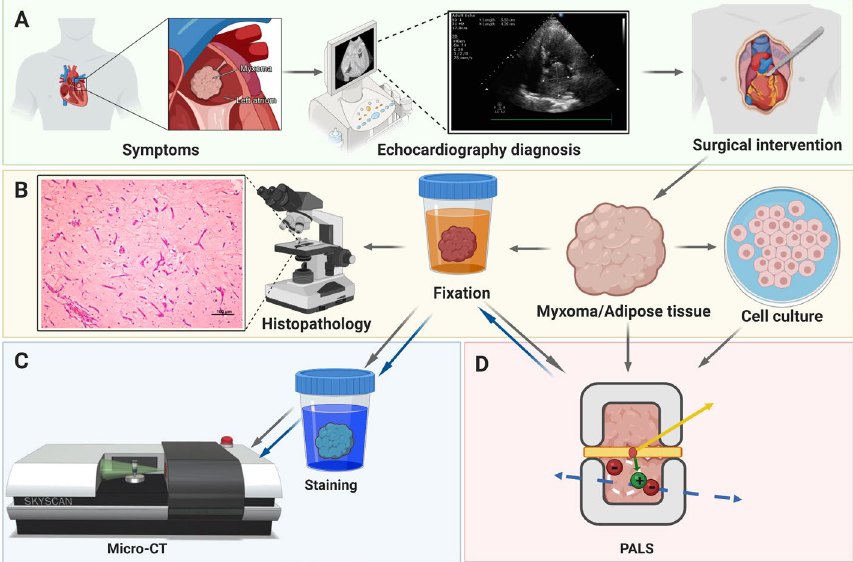
Fig. 3 Cardiac myxoma experiment workflow. a The clinical examination of a symptomatic patient by transthoracic echocardiography and surgical excision of cardiac myxoma (CM). b Sample preparation and examination of myxoma, adipose tissues and CM cells: one piece of CM was fixed for histopathology examination (H&E), while other piece of CM and adipose tissue samples have been used for studying their positronium properties and later fixed for the X-ray imaging (micro-CT). CM cell culture has been derived from the part of tissue designated for PALS experiment before fixation. c Micro-CT imaging: staining in Lugol solution for 5 days and micro-CT scanning; gray and blue arrows represent a workflow for two different scanning runs: before and after positronium measurement (PALS). d A chamber for ortho-Positronium lifetime measurement comprising CM or adipose sample with the 22 Na radionuclide (red dot) emits (green arrow) a positron ( ) and a prompt photon (yellow arrow). Positron and electron from a sample create a + positronium atom (bound state of electron and positron), indicated pictorially by a white dotted circle.